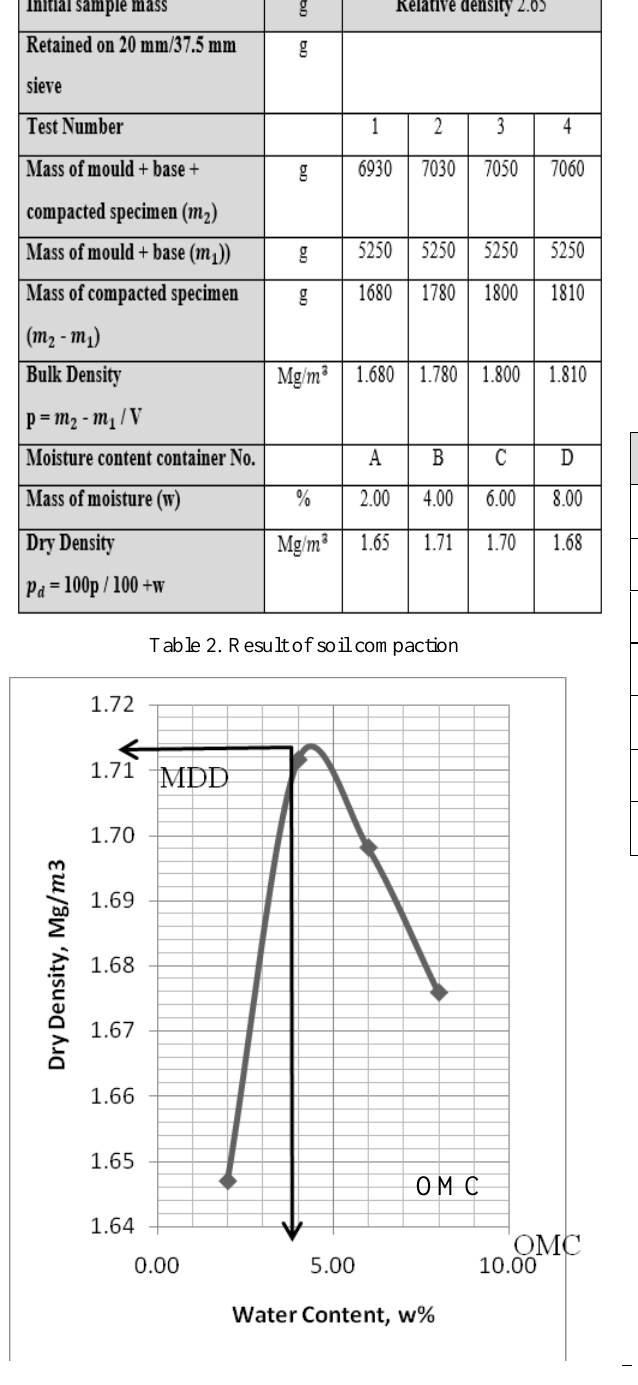
Figure 8 . Relationship of dry density and moisture content